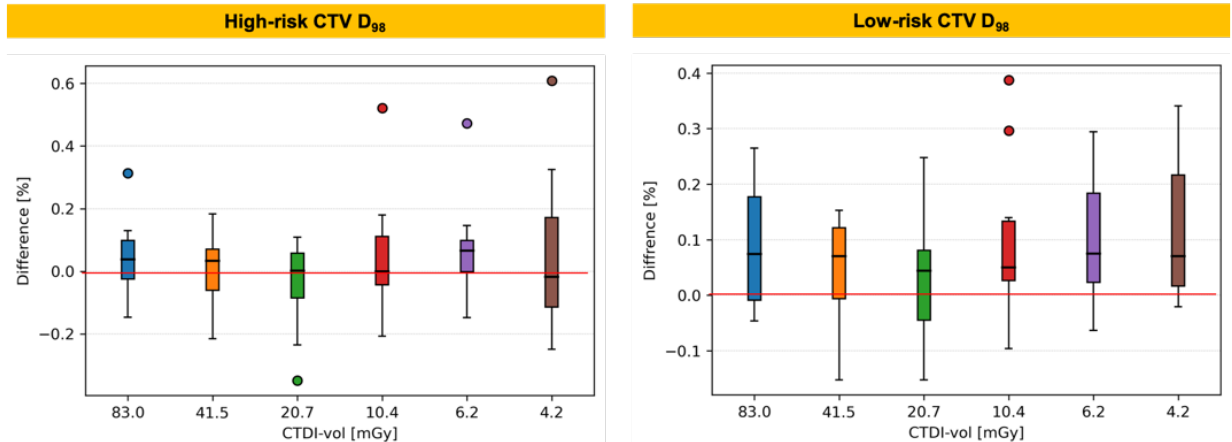
Figure 6. Percentage difference in target coverage ( D 98 ) between low-dose protocols and the reference standard protocol. Boxplots show: median (horizontal bar), Q1–Q3 (25th–75th) percentile (rectangle), 1.5 × (Q3–Q1) interquartile range (whiskers), outliers (dots).